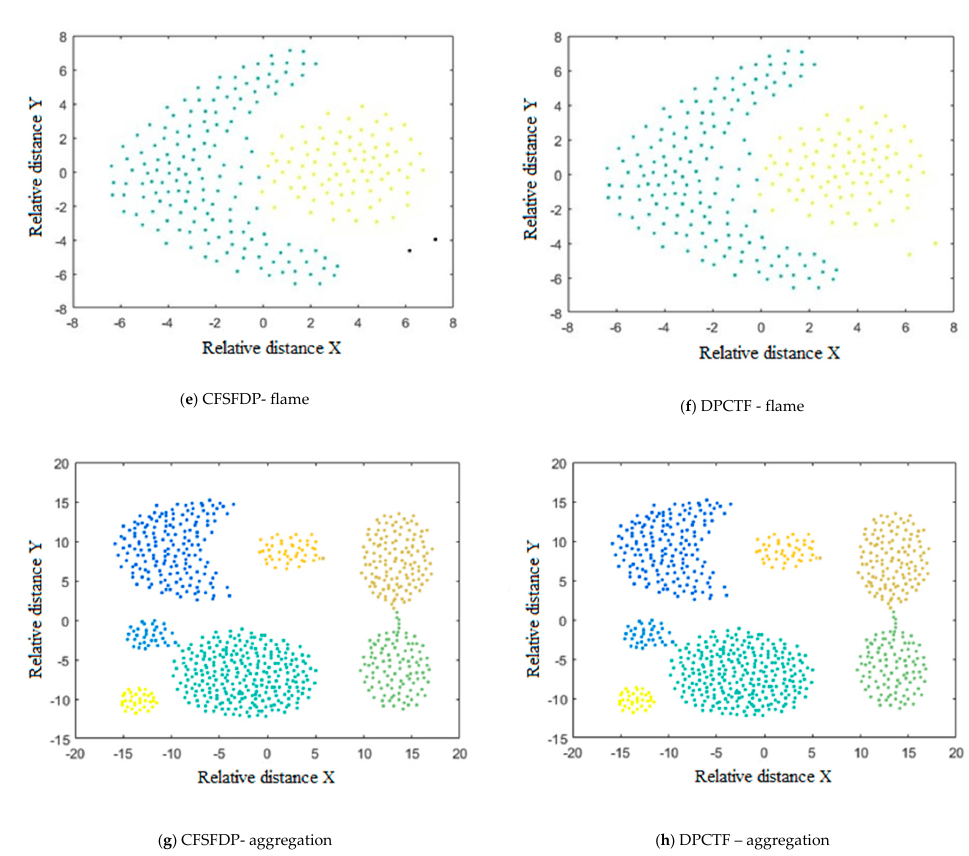
Figure 8. In the picture shown, X and Y represent relative distance. It can be seen from the comparison results that there is a big gap between the results of the comparison experiment formed by ( a ) and ( b ), and the clustering results of ( c ) and ( d ) at the two most marginal data points are different, while there is no difference between the results of the comparison experiment of ( e ) and ( f ), ( g ) and ( h ).